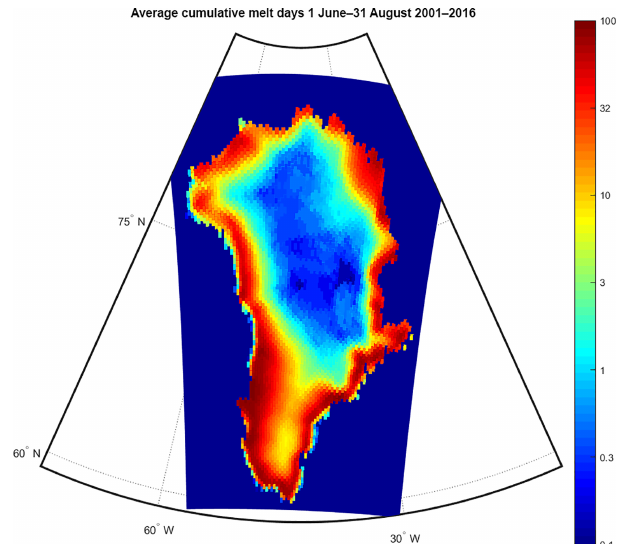
Figure 7. Average number of melt days experienced from 1 June to 31 August as determined from spaceborne passive microwave data (Tedesco, 2014). Note that the NE GrIS high-elevation areas show only a few melt days, almost entirely from 2012. The pattern of melt is inconsistent with the pattern of NIR albedo change. Both low and high elevations in central and NE Greenland show NIR albedo in- creases while only low elevations experience melt (and the dura- tion is in fact increasing, not shown). Additionally, the boundary between NIR albedo positive and negative trends falls in the middle of the area with little melt but closely tracks the summit ridge of the ice sheet, suggesting it is accumulation related rather than melt